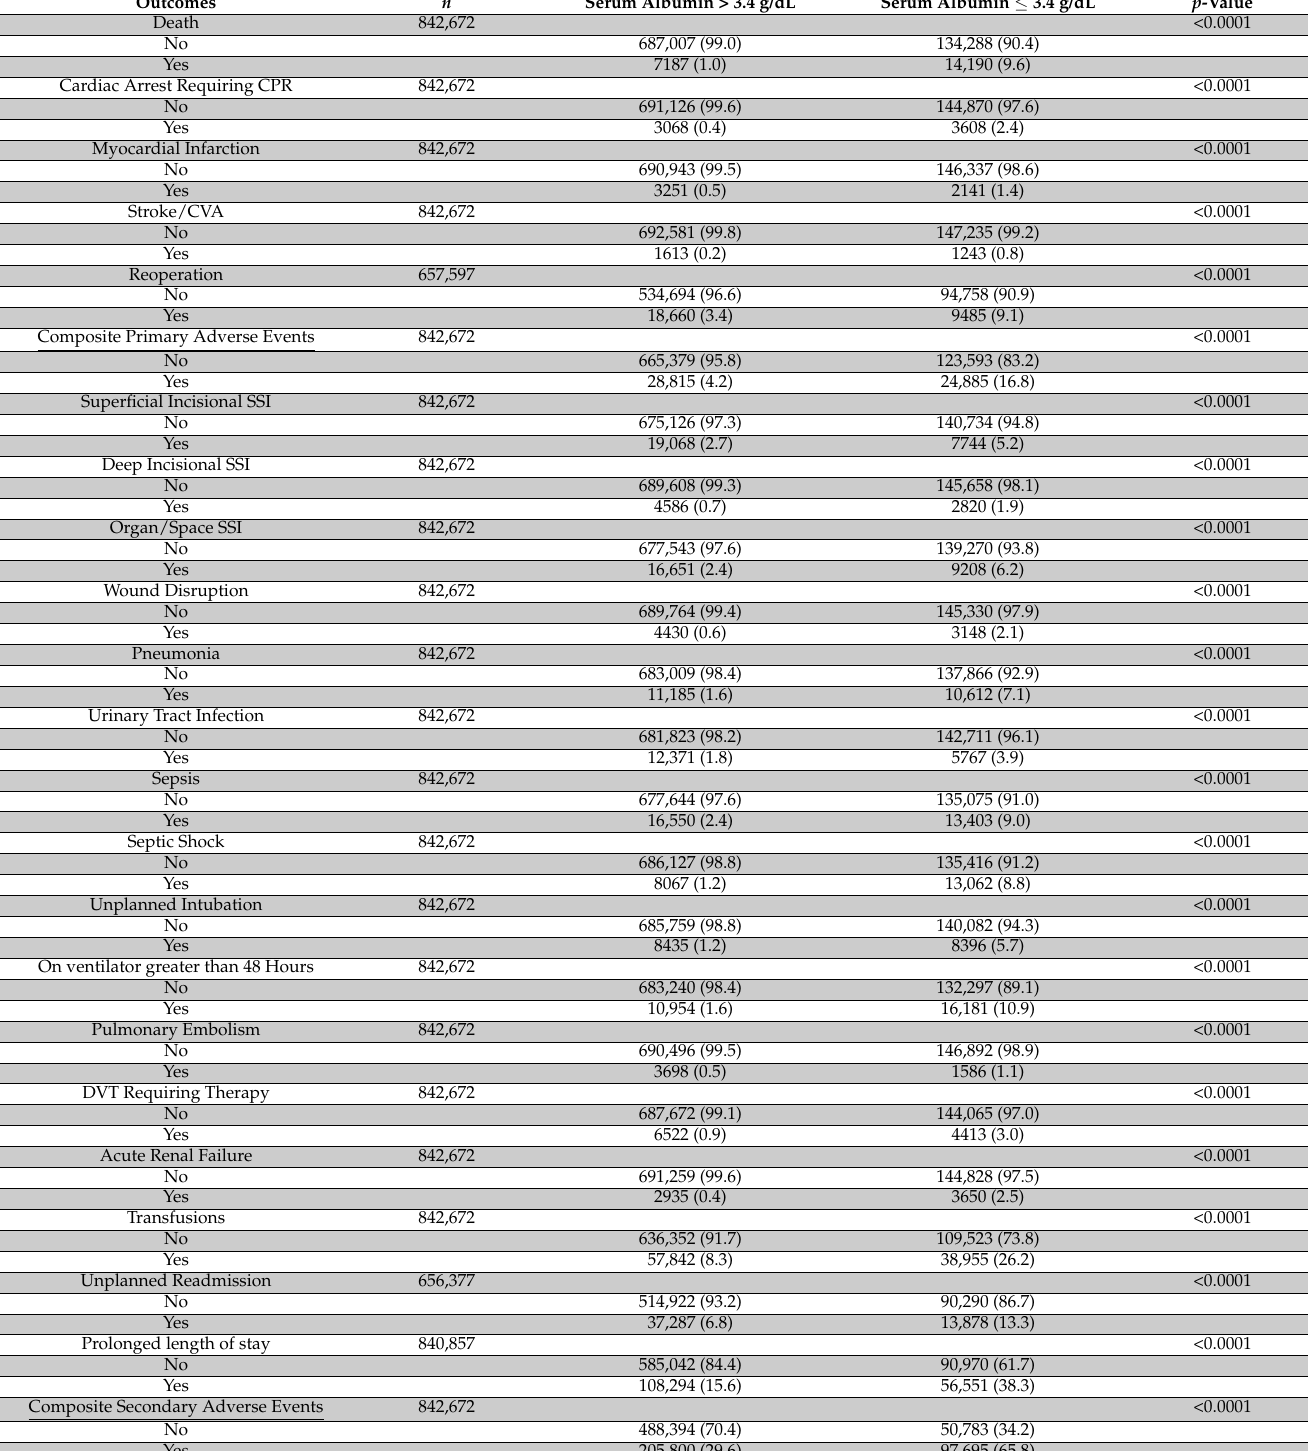
Table 3. Crude Rates of Surgical